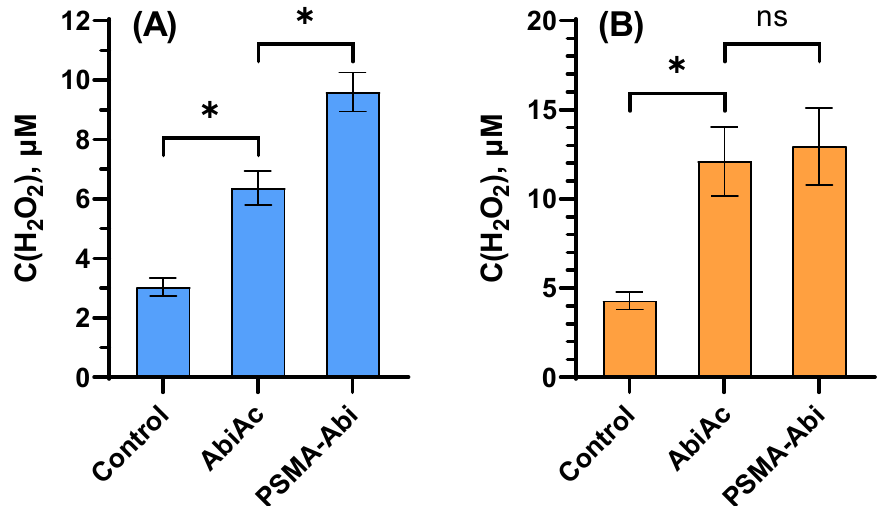
Figure 1. Comparison of the level of ROS/RNS inside the cells of 22Rv1 ( A ) and PC-3 ( B ) under the influence of AbiAc and PSMA-Abi (PSMA-Abiraterone). Cells were incubated for 1 h in RPMI-1640 (1% FBS) at 37 ◦ C, 5% CO 2 with anticancer drugs (IC 50 concentration for each cell line). Results are shown as means ± SEM. *: p < 0.05 (one-way ANOVA).